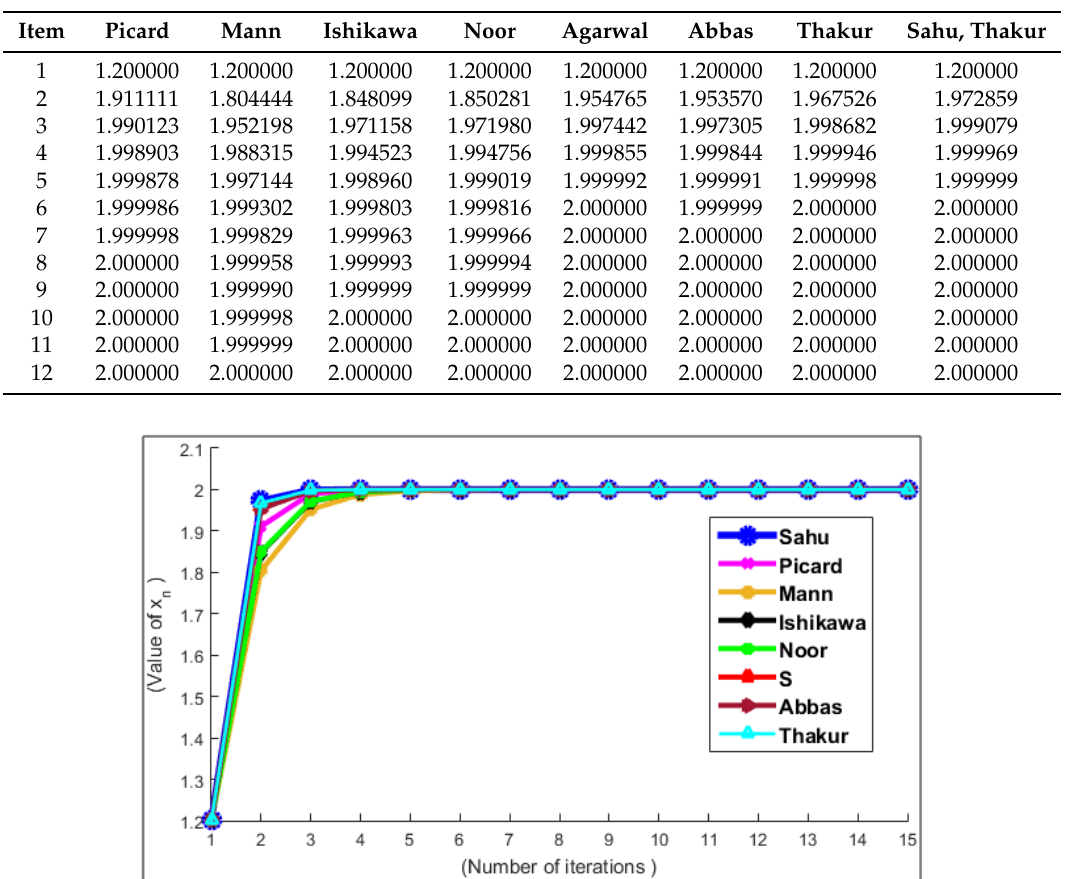
Table 1. A comparison table of iterative schemes.